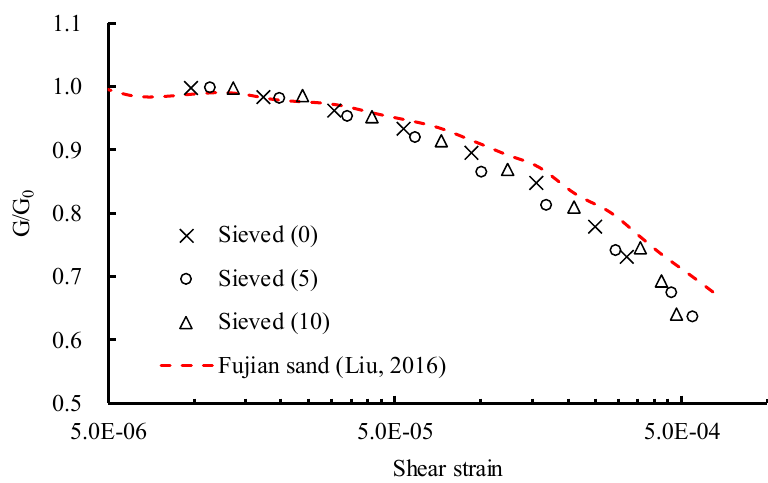
Figure 8. Modulus reduction curves of the rubber–calcareous sand mixtures.